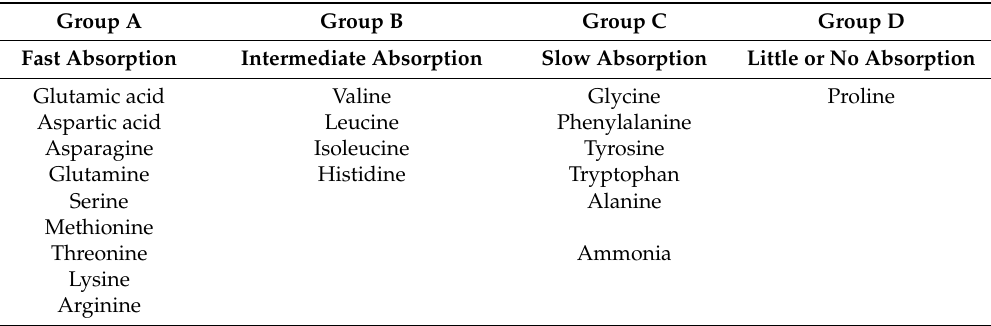
Table 4. Order of wort amino acids and ammonia uptake during fermentation [40,46]. Group